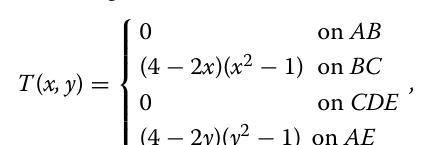
A four-modes SAR of the domain geometry is shown in Fig.